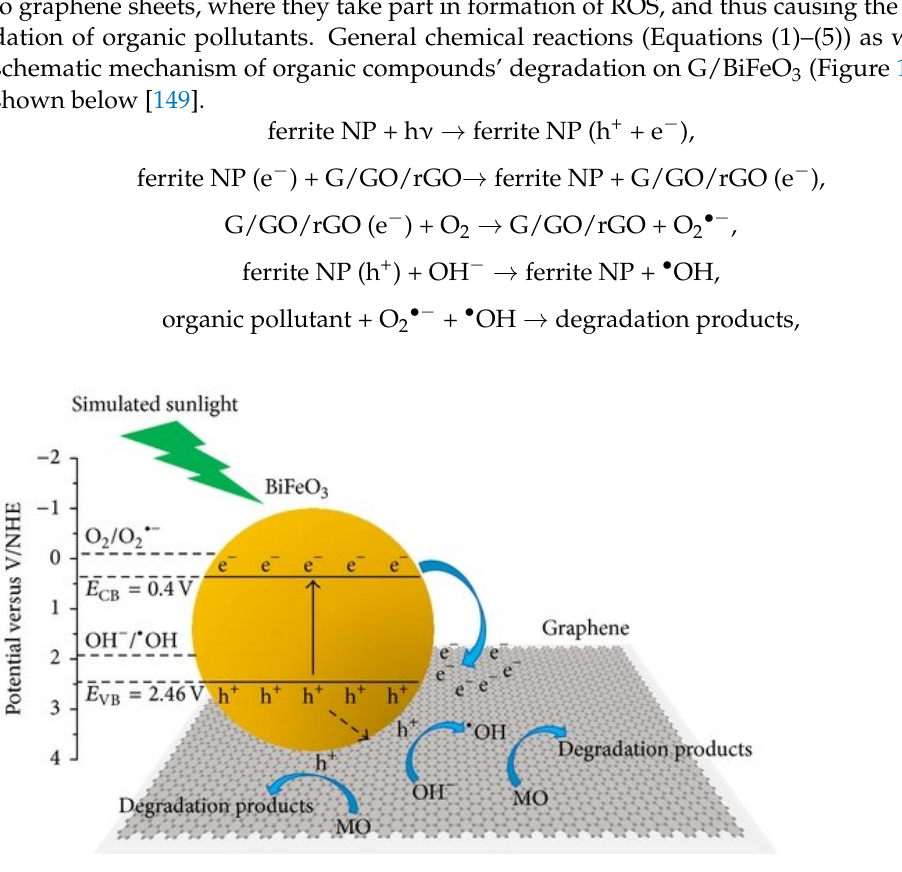
Figure 15. Schematic mechanism of photodegradation of organic pollutants on BiFeO 3 -graphene heterojunction. Reprinted with permission from [149]. Copyright (2013) Creative Commons At- tribution.